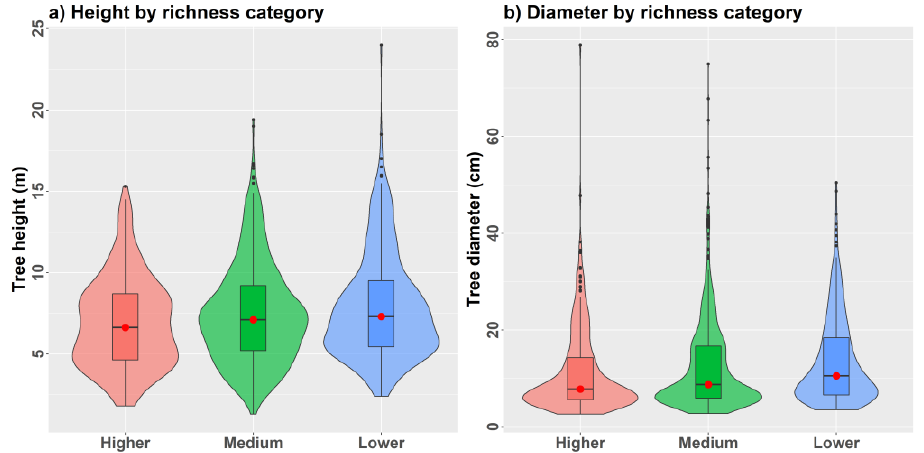
Figure 11. Violin plots of ( a ) tree height and ( b ) tree diameter distributions comparing regularly spaced 0.10 ha validation plots ( n = 25) grouped by lower (<15), medium (15 to 19), and higher (≥20) species richness.